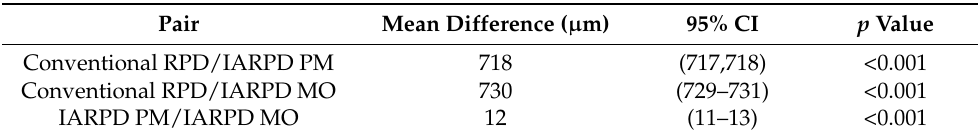
Table 5. Mean differences in the magnitude of displacement of the prosthesis (framework and acrylic) between pairs of models. Statistical analysis with two sample t -tests, assuming unequal variances and Bonferroni correction. 95% CI − 95% confidence interval for the difference.